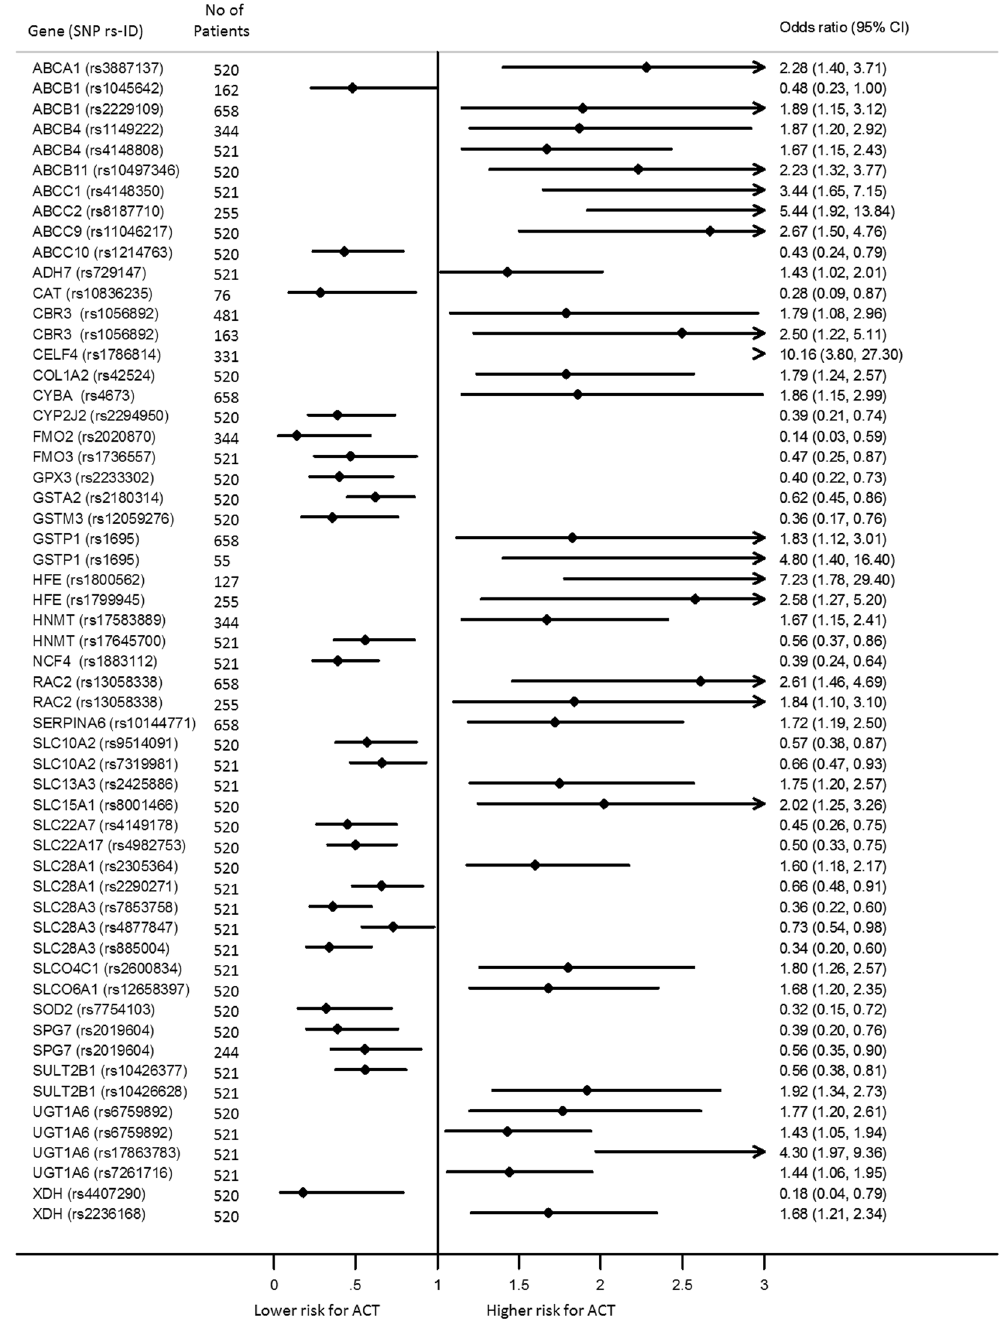
Figure 2. Forest plot of SNPs which examined the association of developing anthracycline-induced cardiotoxicity. SNPs significantly associated with ACT with no odds ratio or confidence interval reported are ABCC1 (rs3743527, rs246221, rs45511401), ABCC5 (rs7627754), AKR1C4 (rs7083869, rs2151896), CBR3 (rs10483032), CYP1A2 (rs2069522, rs2069526, rs4646427), CYP2B6 (rs7255904, rs1709115), CYP4B1 (rs837400, rs4646495), CYP4F11 (rs8112732, rs12610962, rs2072270), HSD17B2 (rs16956248, rs13333826, rs7196087, rs2955159, rs2966245), HSD17B4 (rs257970, rs2636968), KCNH2 (rs3807375), POR (rs2868177, rs13240755, rs4732513), SLC22A17 (rs11625724, rs12882406, rs12896494). The diamond in each line represents the effect estimate and weight of each study. The width of the line across the diamond shows the 95% confidence interval of the effect estimate of individual studies. ACT, Anthracycline-induced cardiotoxicity; CI, confidence